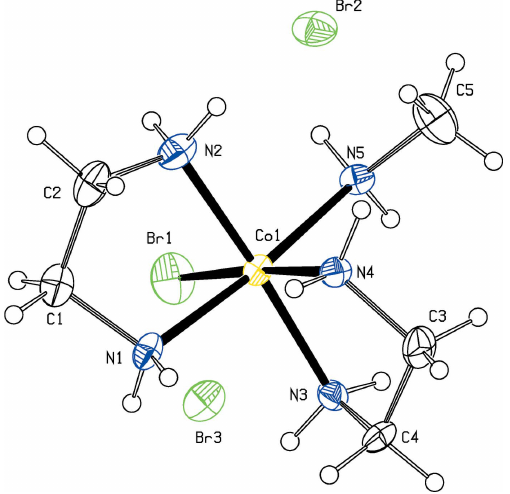
Figure 1 Molecular structure of the title compound, with atom labelling. Displacement ellipsoids are drawn at the 30% probability